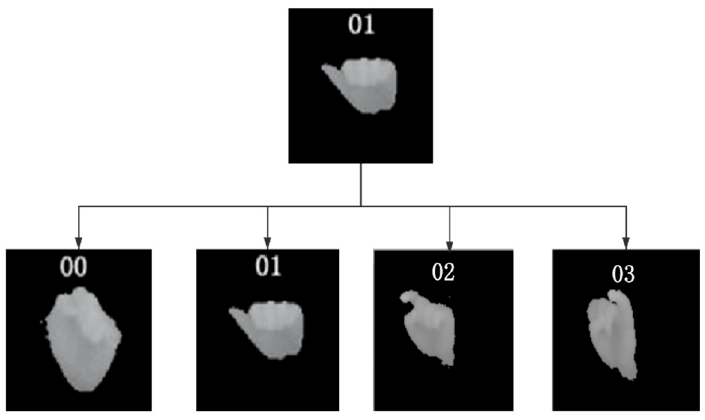
Figure 8. Grayscale diagram of gesture of the elderly.